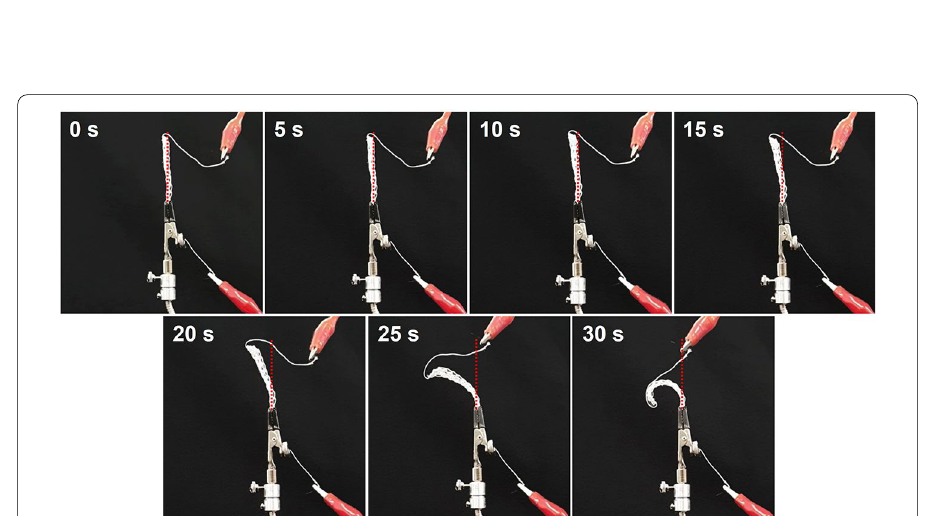
Fig. 6 Bending angle changes of the knitted shape memory alloy module over